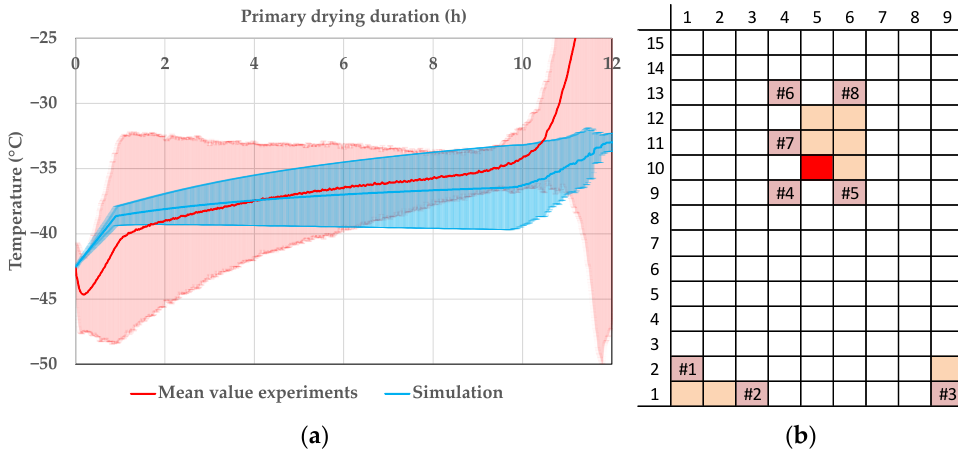
Figure 13. ( a ) Product temperature profile of vial 10.5 during primary drying at the CP. ( b ) Vial position (red: shown vial, orange: other probed vials, pink: WTMplus sensor position and WTMplus number).